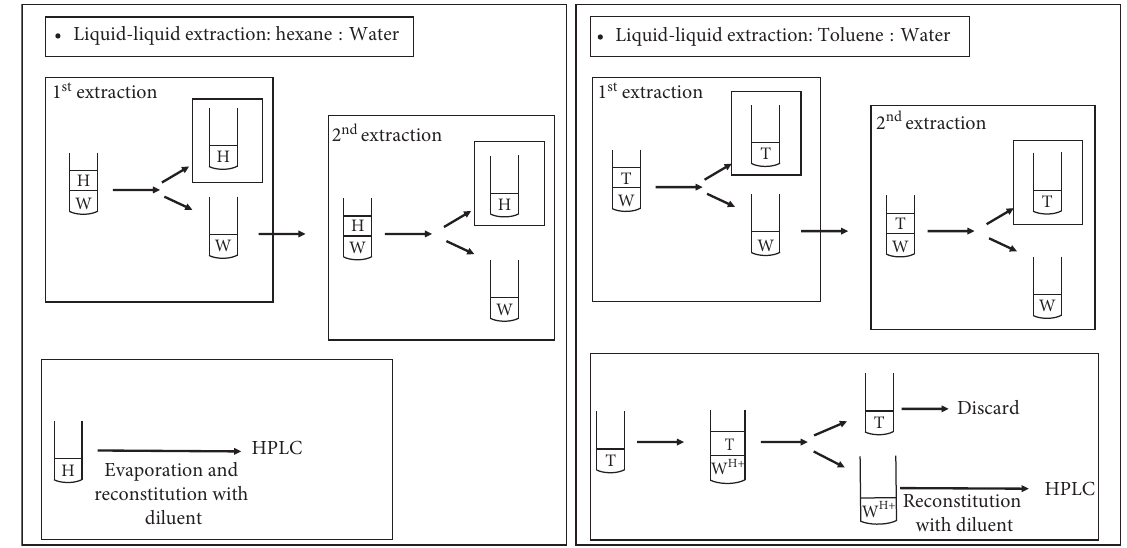
Figure 3: Schematic of methodology of measurement of free base and protonated nicotine by extraction using hexane (H) or toluene (T) in water (W) or acid (W H+